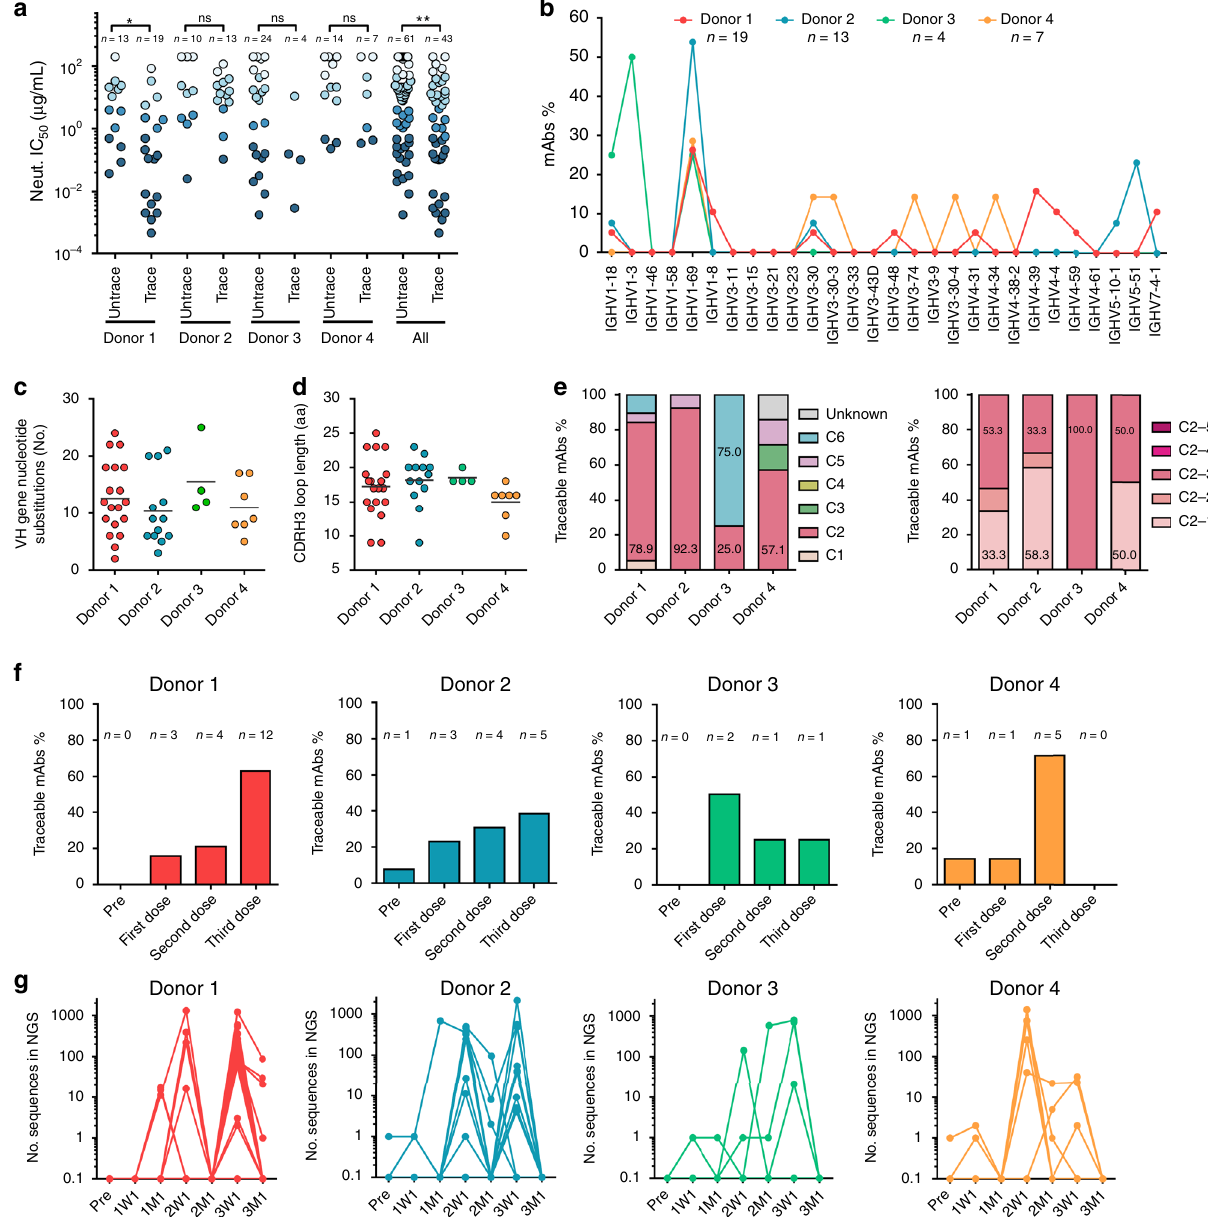
Fig. 5 An overview of HEV p239(1)-speci fi c mAbs in terms of lineage traceability in the unbiased repertoires. a Analysis of neutralizing activity between lineage-traceable and untraceable mAb groups. There are 19 lineage-traceable mAbs from donor 1, 13 from donor 2, 4 from donor 3, and 7 from donor 4. There are 13 lineage-untraceable mAbs from donor 1, 10 from donor 2, 24 from donor 3, and 14 from donor 4. b Distribution of traceable heavy-chain variable (VH) germline genes. Donors 1, 2, 3, and 4 are indicated by red, cyan, green, and orange, respectively. c Distribution of nucleotide mutations in the traceable VH gene. Black bars indicate the mean value. d Distribution of heavy-chain complementarity-determining region 3 (CDRH3) lengths (amino acids, aa). Black bars indicate the mean value. There are 19 mAbs from donor 1, 13 from donor 2, 4 from donor 3, and 7 from donor 4 in ( c ) and ( d ) with each colored circle indicating an mAb. e Epitope analysis of lineage-traceable mAbs for four donors. f Time points at which the HEV-speci fi c mAbs were fi rst identi fi ed in the donor repertoires. g Temporal distribution of lineage size, measured as the number of CDRH3-de fi ned somatic variants, of the traceable HEV p239(1)-speci fi c mAbs in the donor repertoires. Pre: pre-vaccination; 1W1: 1 week after the fi rst dose; 1M1: 1 month after the fi rst dose; 2W1: 1 week after the second dose; 2M1: 1 month after the second dose; 3W1: 1 week after the third dose; 3M1: 1 month after the third dose. Source data are provided in the Source Data fi